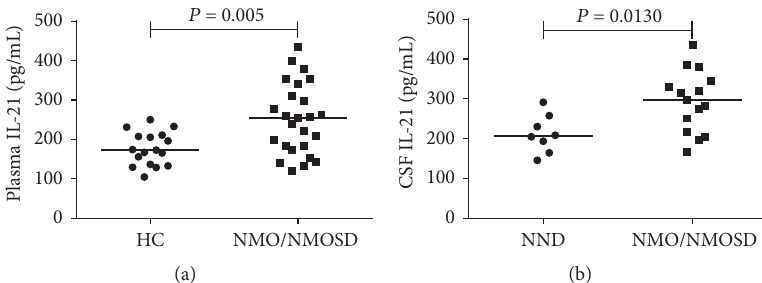
Figure 5: Analysis of plasma and CSF IL-21 in NMO/NMOSD patients. The levels of plasma and CSF IL-21 were measured by ELISA. (a) The levels of plasma IL-21 in NMO/NMOSD patients and HCs. (b) The levels of CSF IL-21 in NMO/NMOSD patients and NND patients. Data are expressed as mean values for individual samples. The horizontal lines represent the median